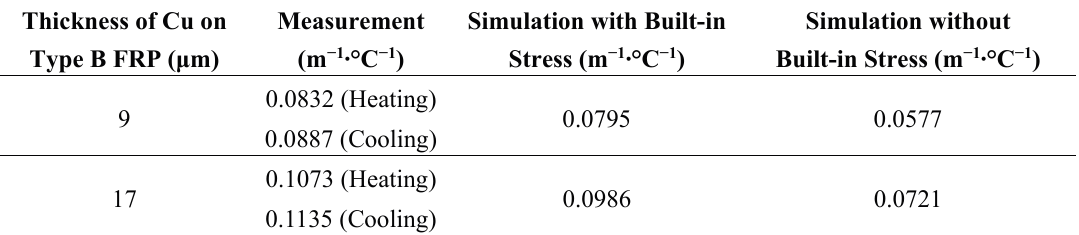
Table 3. The comparison of the dC / dT values for measurement, simulation with and without built in stress of type B FRP substrates.